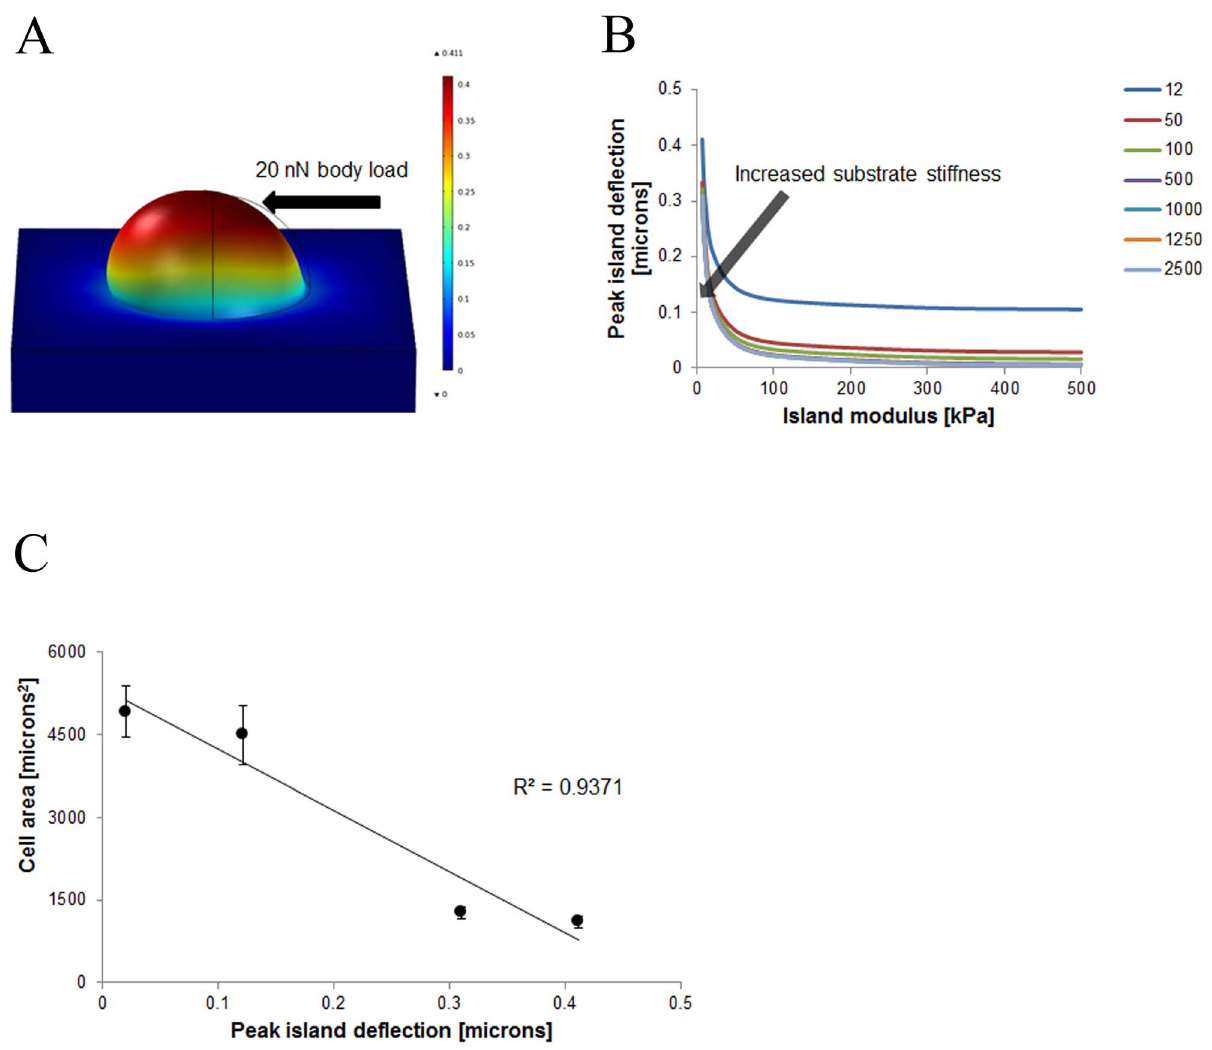
Figure 4. Patterned hydrogel islands were analyzed to engineer substrate elasticity. (A) Conceptual illustration of horizontal cell traction force of 20 nN on hydrogel island and analysis of deflection of individual island. (B) Hydrogel island deflection is plotted as a function of island modulus with differing background elasticities plotted. (C) Cell area of 12 m m spacing cases plotted versus correlating model peak deflections to show correlation between modeling and experimental components.